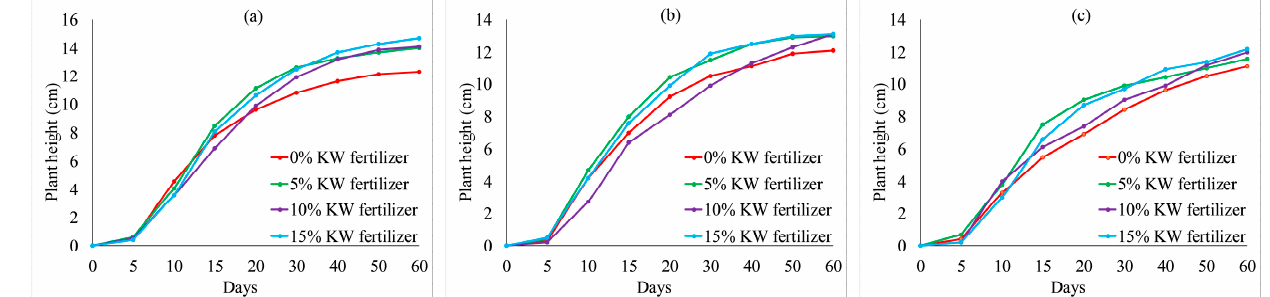
Figure 9. Festuca elata height relative to KW fertilizer content with different percentages of cement: ( a ) 4% cement; ( b ) 8% cement; ( c ) 12% cement.